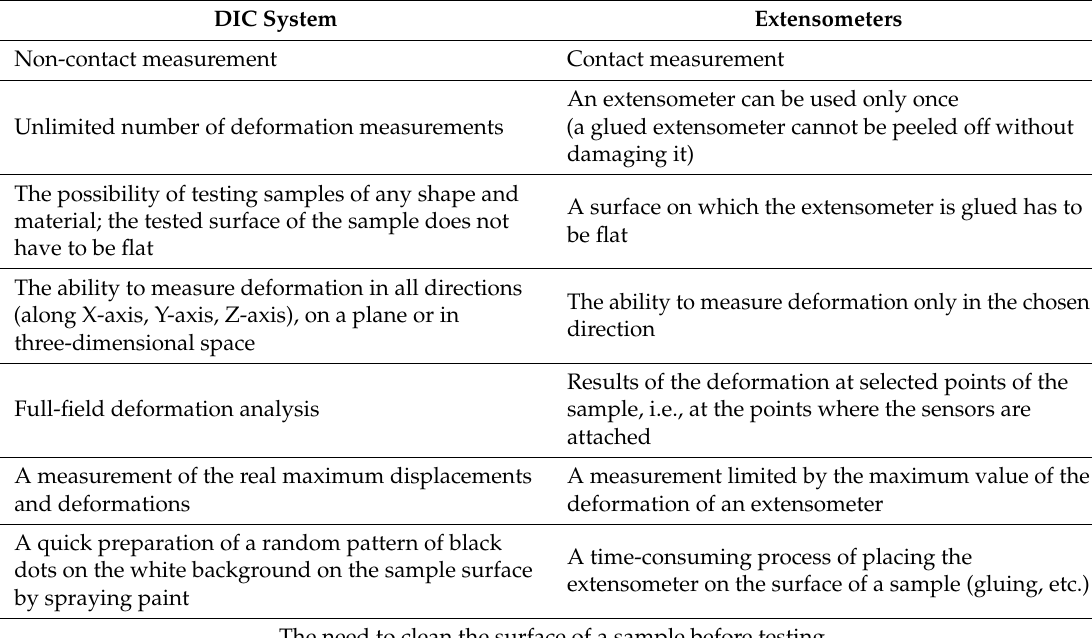
Table 1. Comparison of the DIC method with measurements by using extensometers [5,8,16]. DIC System Contact measurement An extensometer can be used only once Unlimited number of deformation measurements (a glued extensometer cannot be peeled o ff without damaging it) The possibility of testing samples of any shape and A surface on which the extensometer is glued has to material; the tested surface of the sample does not be flat have to be flat The ability to measure deformation in all directions The ability to measure deformation only in the chosen (along X-axis, Y-axis, Z-axis), on a plane or in direction three-dimensional space Results of the deformation at selected points of the Full-field deformation analysis sample, i.e., at the points where the sensors are attached A measurement of the real maximum displacements A measurement limited by the maximum value of the and deformations deformation of an extensometer A quick preparation of a random pattern of black A time-consuming process of placing the dots on the white background on the sample surface extensometer on the surface of a sample (gluing, by spraying paint